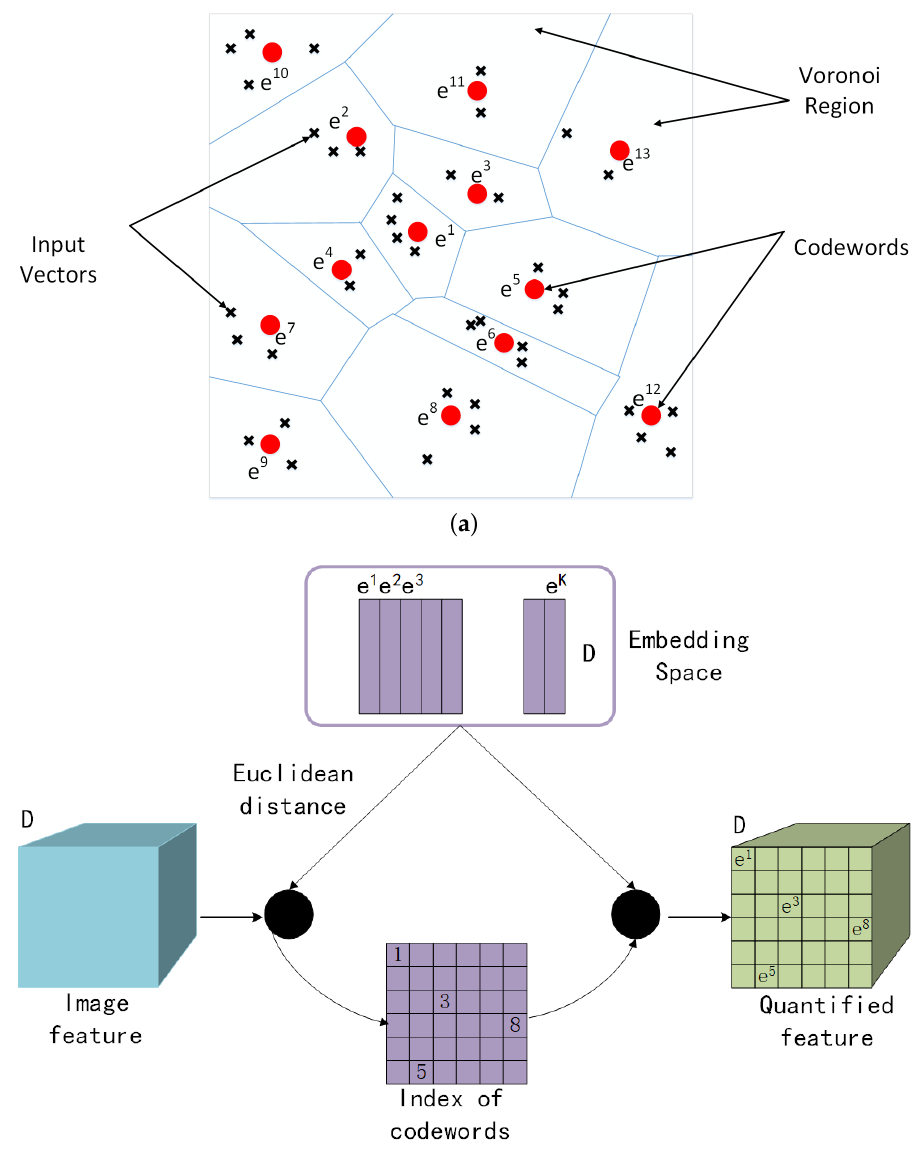
Figure 1. Vector quantization (VQ) diagram. ( a ) Embedded codewords in a two-dimensional space. Input vectors are marked with an x, codewords are marked with red circles, and the Voronoi regions are separated with blue boundary lines. ( b ) The example of VQ applied to image. The blue cube is the input image feature with D dimensions, the green cube is the quantified feature, the purple matrix is the index of codewords, and the embedded codebook is in the purple